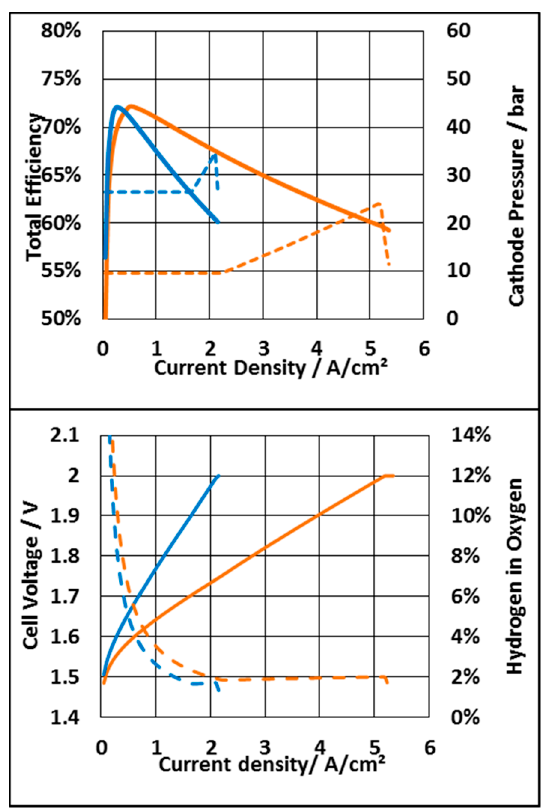
Figure 9. Top : Total efficiency and cathode pressure as a function of current density. Bottom : Polarization curve and hydrogen concentration in oxygen as a function of current density. The colors symbolize the pressure-optimized operation of an N212-based system (orange) with three stages and an N117-based system with two stages (blue).